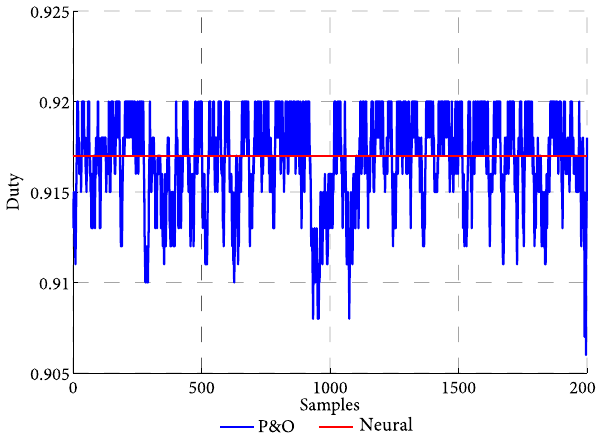
Figure 23. Real system duty cycle.